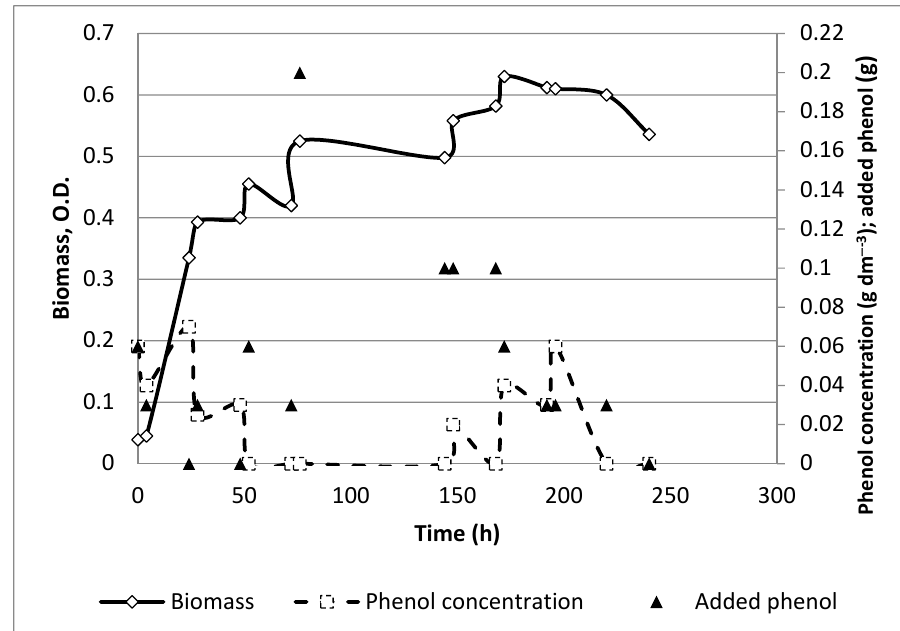
Figure 1. Time profile for control experiment with initial phenol concentration as 0.06 g dm −3 .